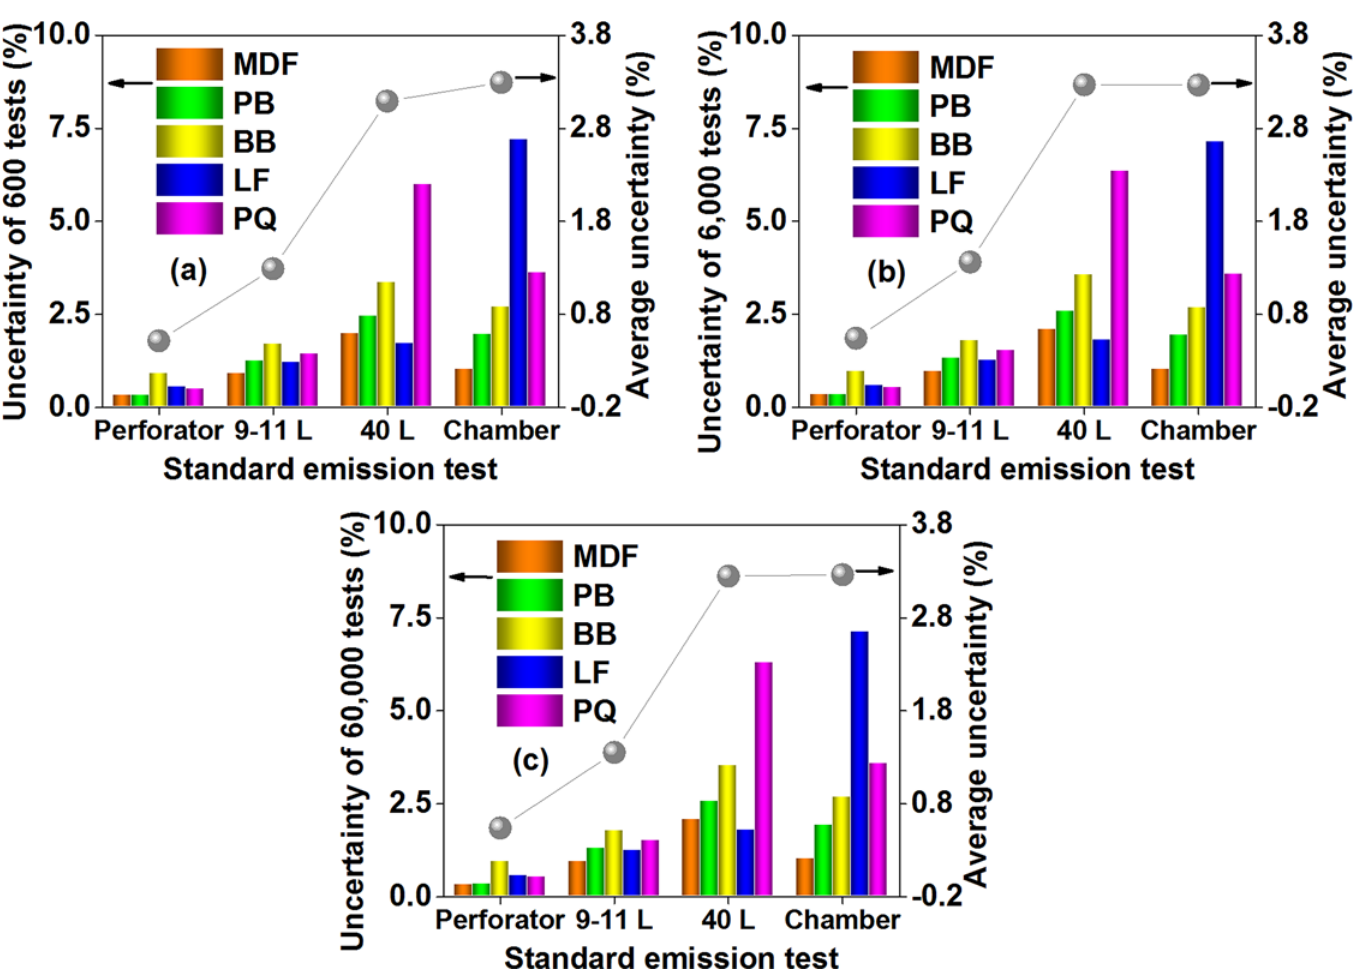
Fig 13. The measurement uncertainty for formaldehyde emission data of various materials characterized by test methods of the Chinese national standard GB 18580, which is evaluated by the Monte Carlo method. (a) The simulation times N of the large scale simulation survey = 600. (b) The simulation times N of the large scale simulation survey = 6,000. (c) The simulation times N of the large scale simulation survey = 60,000. MDF, medium density fiberboard; PB, particleboard; BB, blockboard; LF, laminate flooring; PQ, parquet. Perforator, the perforator extraction method; 9 – 11 L, the 9 – 11 L desiccator method; 40 L, the 40 L desiccator method; Chamber, the environmental chamber method. The “ uncertainty ” denoted the measurement uncertainty for a material-method combination (of the 20 combinations = 5 materials × 4 methods), while the “ average uncertainty ” represented the measurement uncertainty for a method (of the 4 methods), which was the arithmetic mean of the 5 “ uncertainties ” for the the 5 materials studied by this method.